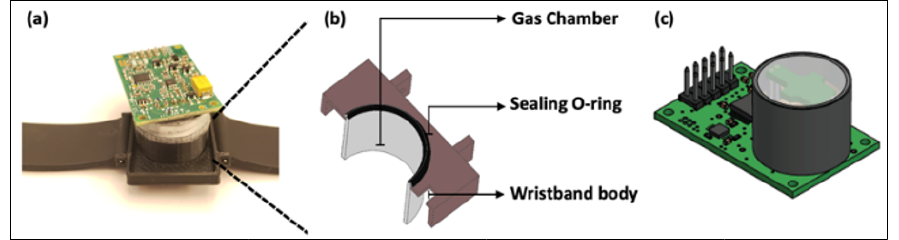
Figure 18. Wearable transcutaneous CO 2 monitor based on miniaturized non-dispersive infrared sensor. ( a ) Image of the integrated wristband, ø20.9 mm × 18.1 mm. ( b ) The zoom-in shows cross- section view of the gas chamber, sealing O-ring, and wristband body. ( c ) Miniaturized Cozir NDIR